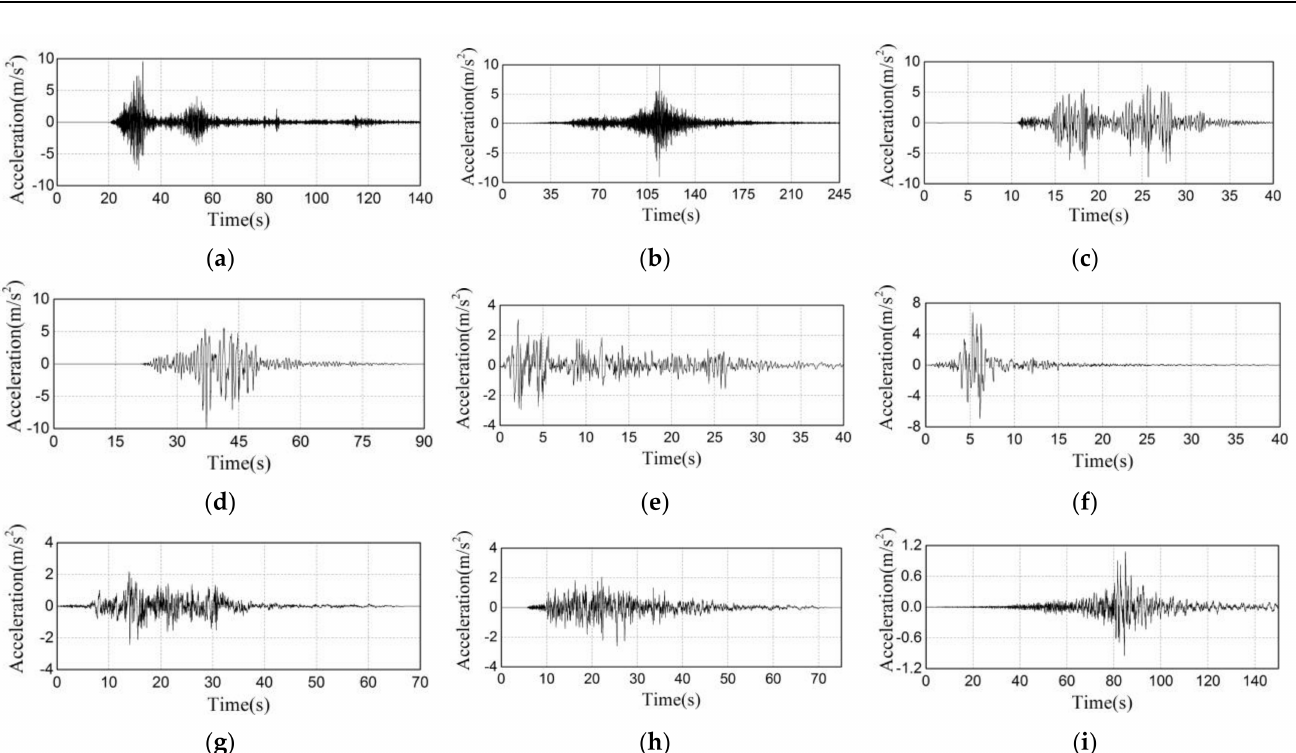
Figure 17. Time histories of input ground motions with ( a ) Wo-long, ( b ) 311, ( c ) IZMIT, ( d ) ChiChi- TCU084, ( e ) ELcentro-BCJ ( f ) Kobe ( g ) ChiChi-TCU049 ( h ) ChiChi-TCU122 and ( i )